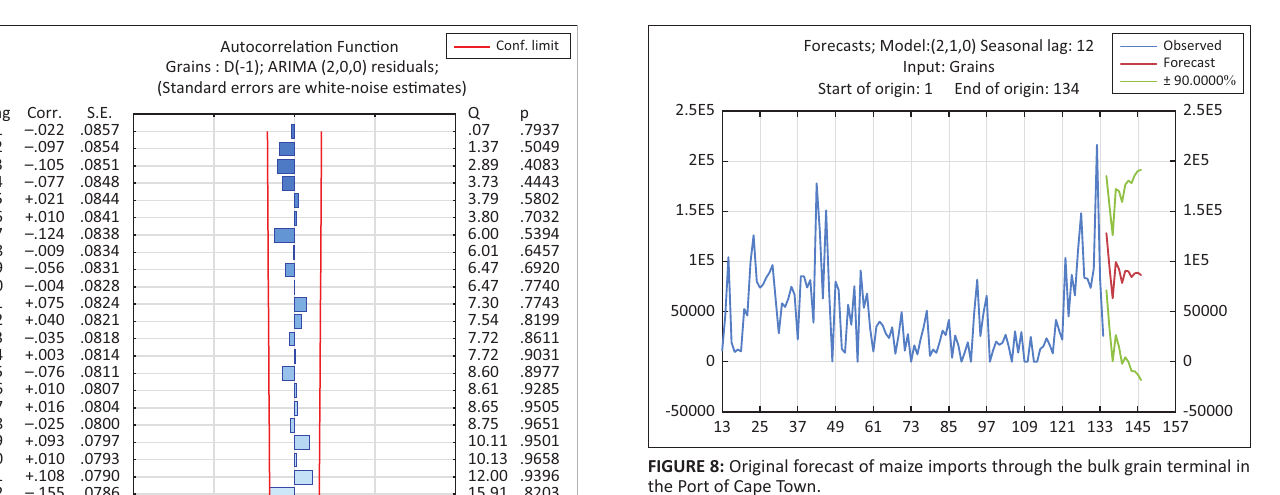
Par(cid:28)al Autocorrela(cid:28)on Func(cid:28)on Maize : ARIMA (1,0,1) residuals; (Standard errors assume AR order of k-1)